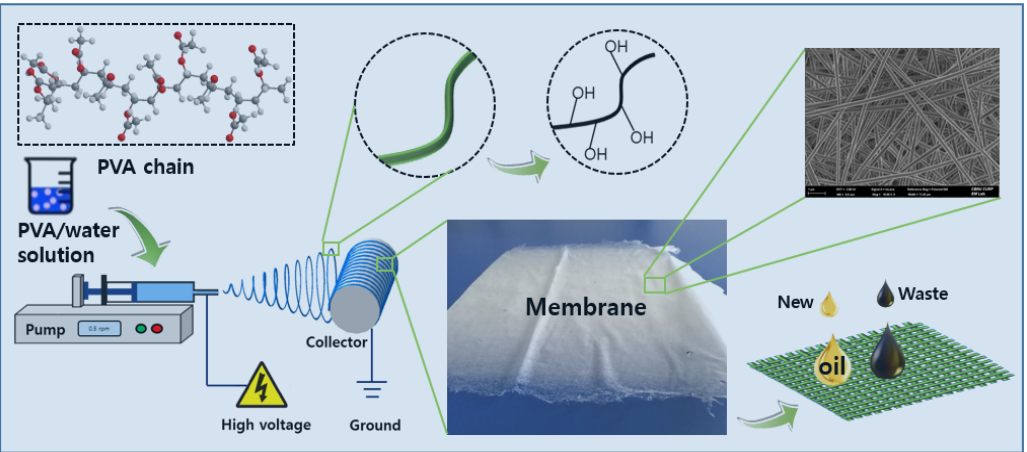
Figure 1. Schematic diagram of the electrospinning system.